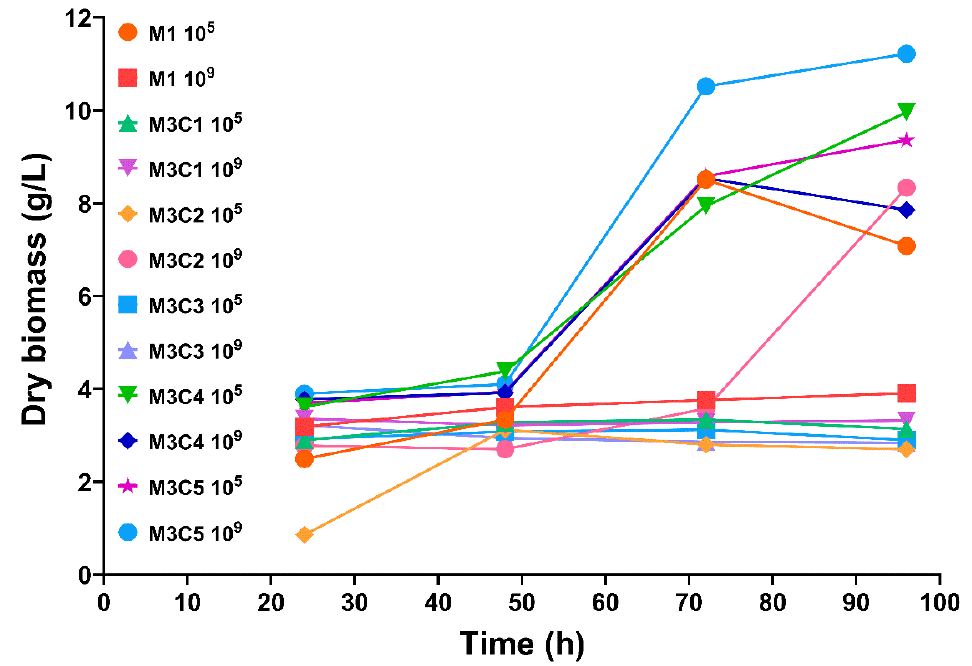
Figure 1. Dry biomass quantification during fermentative processes. Experiments’ codifications are presented in Table 1.